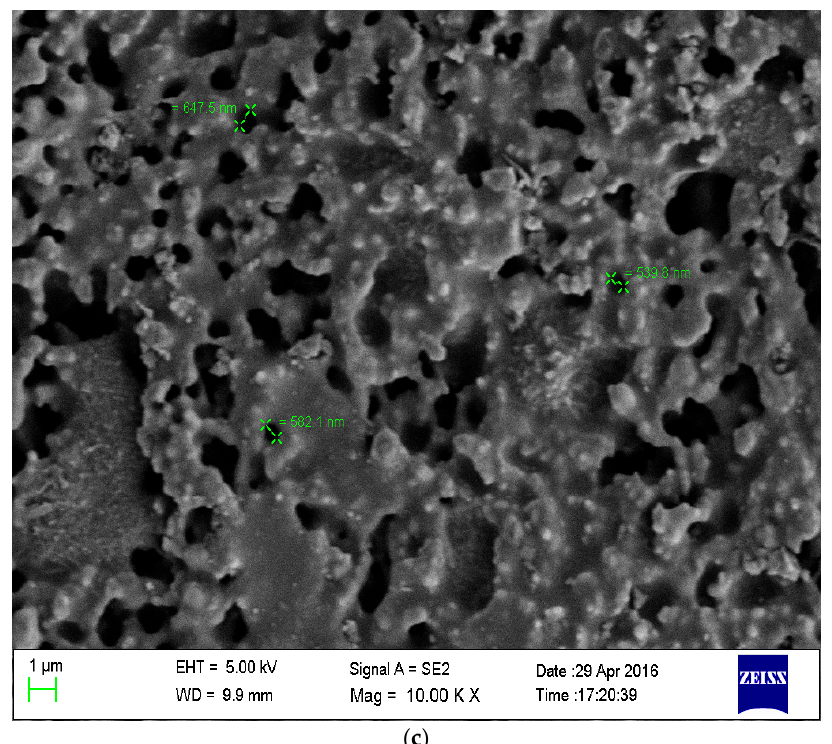
Figure 1. ( a ) SEM image depicting the thickness of the outer SiC coating; ( b ) SEM of uncoated membrane; ( c ) SEM of coated membrane.